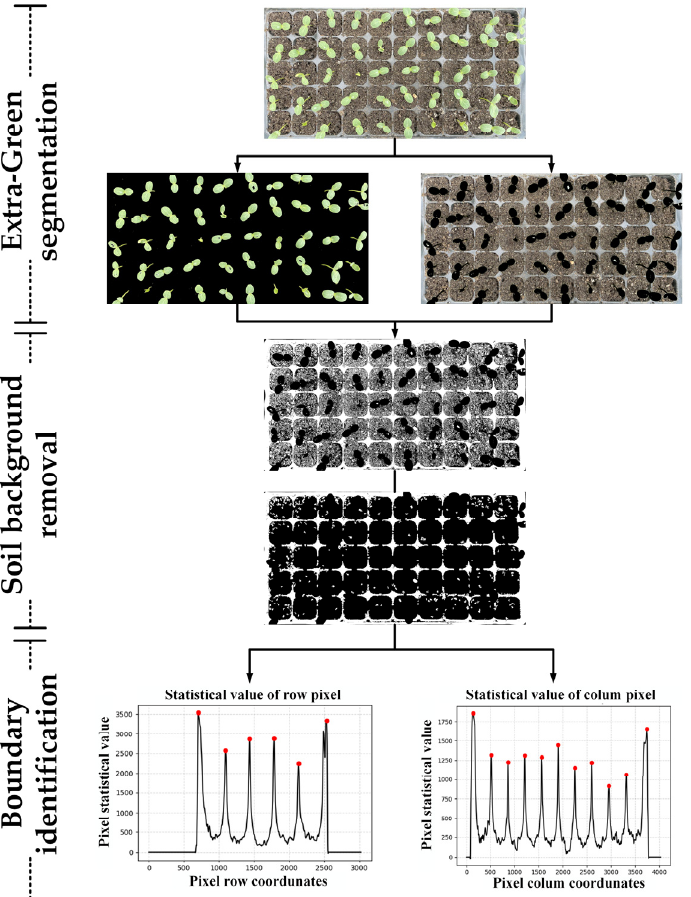
Figure 4. Plug-hole identification process.